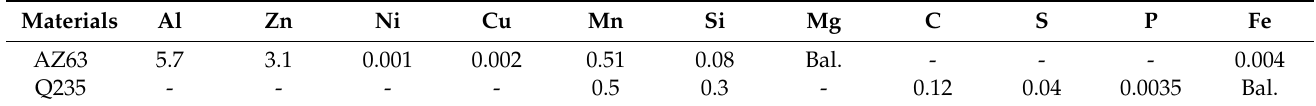
Table 1. Chemical composition of AZ63 and Q235